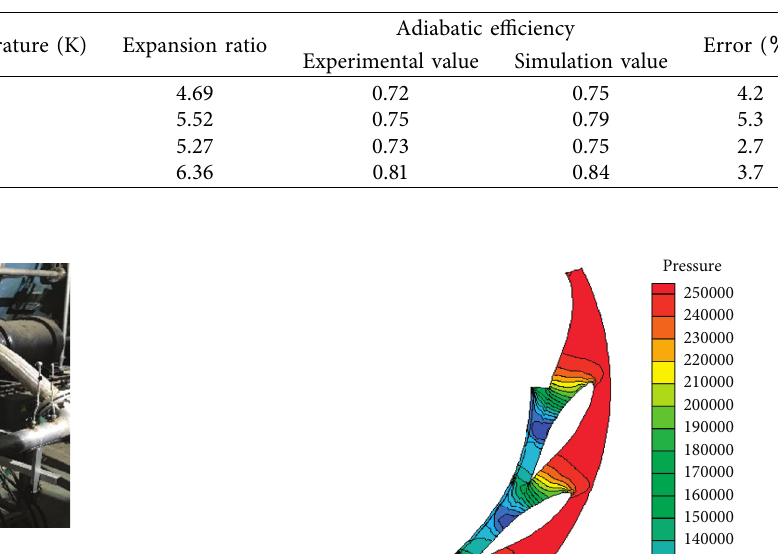
Table 4: The adiabatic efficiency of the turbine in different states.